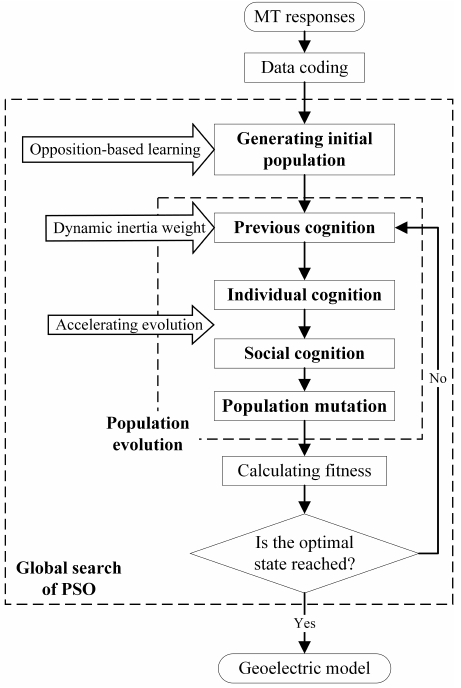
Figure 2. Flow chart of memetic strategy for MT